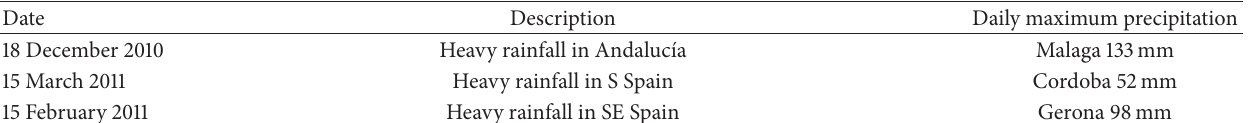
Table 3: Study cases.